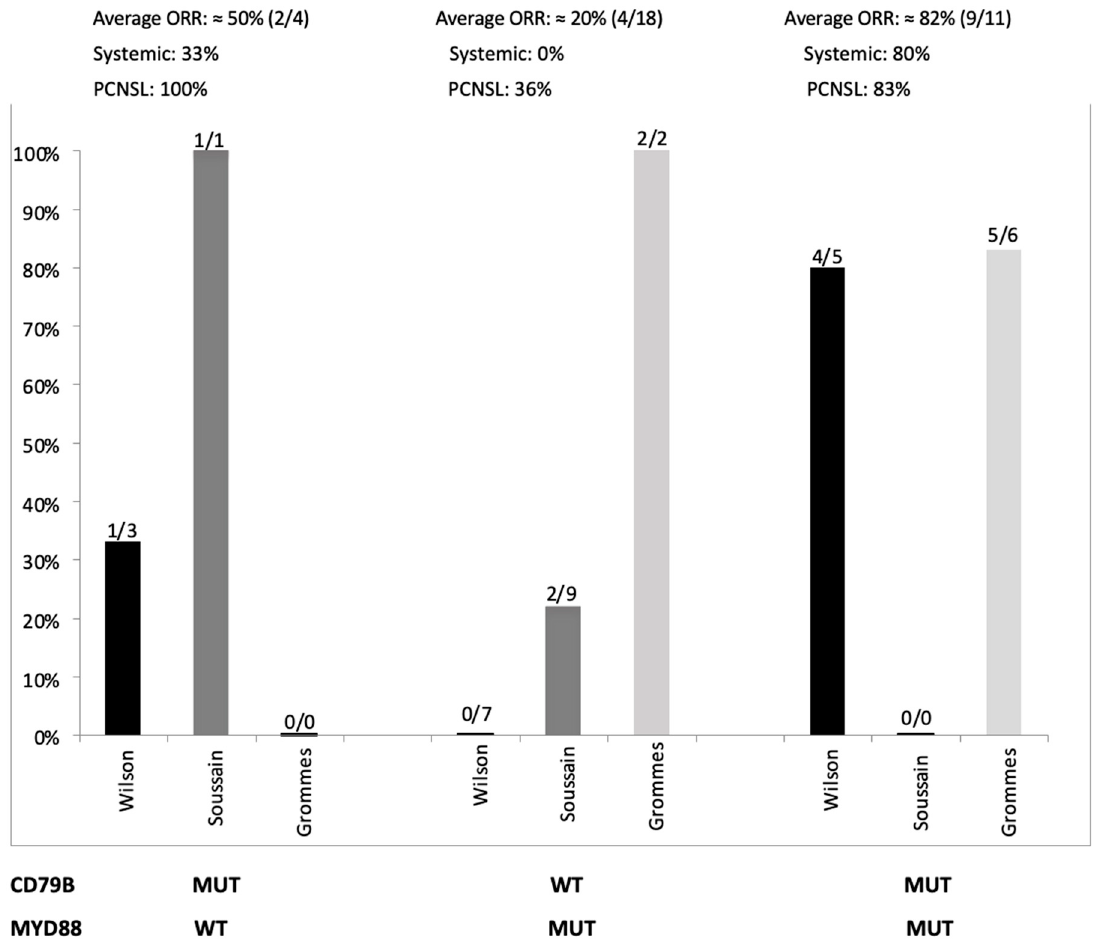
Figure 2. Tumor response rates in three series of patients treated with ibrutinib (Grommes et al. [63], Soussain et al. [64], Wilson et al. [15]) and available mutational status of MYD88 and CD79B. ORR rate for PCNSL refers to the by both Grommes et al. and Soussain et al. [63,64] WT: wild-type; MUT: mutated; ORR: overall response rate; PCNSL: primary central nervous system lymphoma.